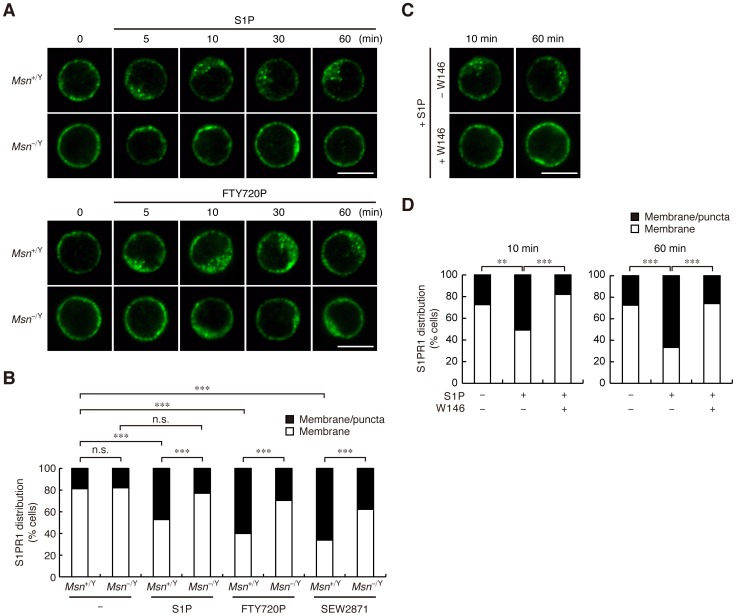
Agonist-induced S1PR1 internalization is impaired in moesin-deficient T cells.(A) S1PR1 localization in CD4+ T cells. Lymph node CD4+ T cells from Msn
+/Y and Msn
−/Y mice were treated with or without 100 nM S1P or 100 nM FTY720P for the indicated times. Cells were fixed, permeabilized, and stained with anti-S1PR1 antibody. Representative confocal images are shown. Scale bars, 5 µm. (B) Quantification of S1PR1 internalization. Lymph node CD4+ T cells from Msn
+/Y and Msn
−/Y mice were incubated with or without 100 nM S1P, 100 nM FTY720P, or 1 µM SEW2871 for 1 h. Cells were stained as in (A). Cell percentages with the indicated S1PR1 localization pattern are shown. (C) The effect of W146 on S1P-induced S1PR1 relocalization. Lymph node CD4+ T cells from WT mice were incubated with or without 1 µM W146 for 30 min and then stimulated with 100 nM S1P for 10 or 60 min. Cells were stained as in (A). Representative confocal images are shown. Scale bar, 5 µm. (D) Quantification of the effect of W146. Percentages of cells with the indicated distribution patterns of S1PR1 were determined. (B and D) n>50 cells for each group. ***, P<0.001; **, P<0.01; n.s., not significant (Fisher's exact test).